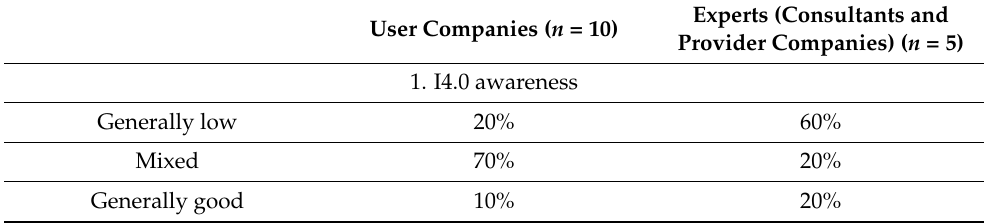
Table 3. Comparative analysis: users vs.